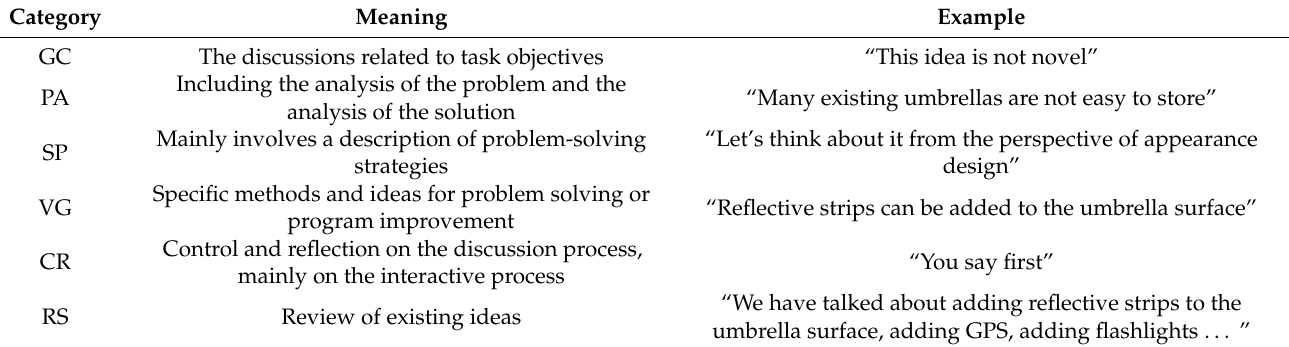
Table 1. The meaning and examples of utterance categories.